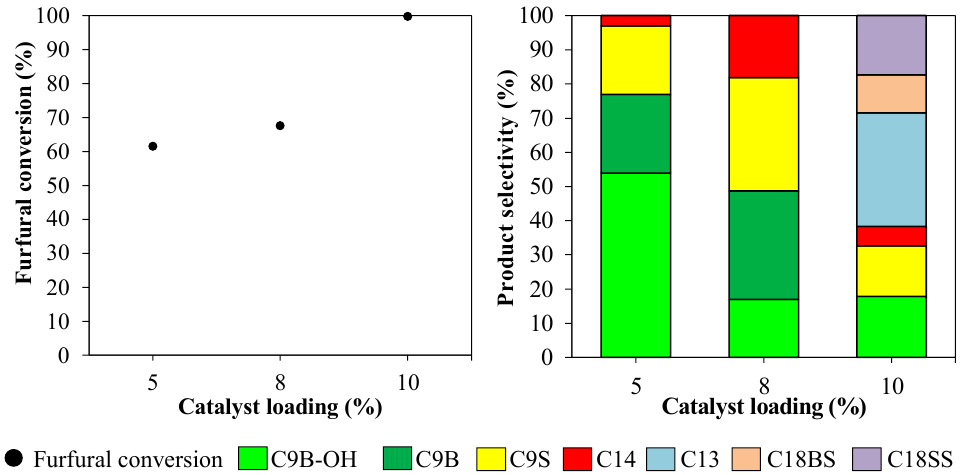
Figure 6. Effect of reactants molar ratio on furfural conversion and product selectivity obtained from aldol condensation of furfural and 2-butanone over LDO3 catalyst. (Reaction conditions: catalyst loading, 5 wt.%; time, 8 h; temperature, 80 °C; N 2 pressure, 10 bar).